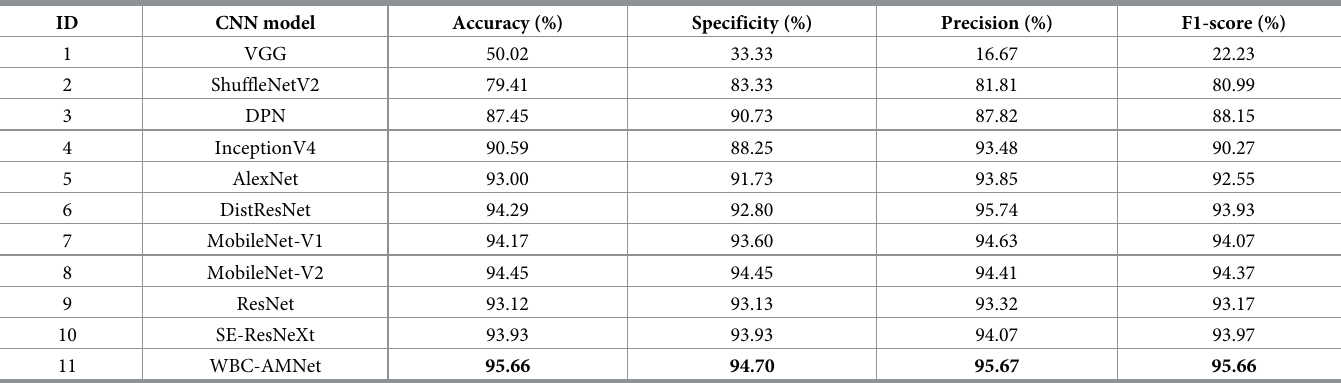
Table 5. Training results when epoch = 20 and batch size = 32.